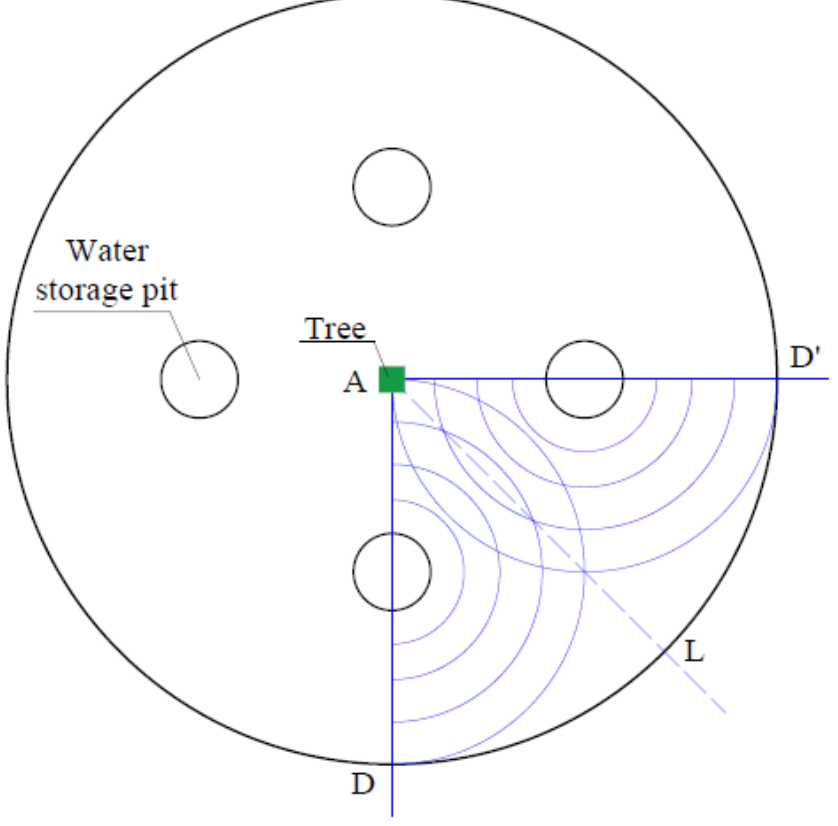
Figure 5. Field layout of water storage pit irrigation.